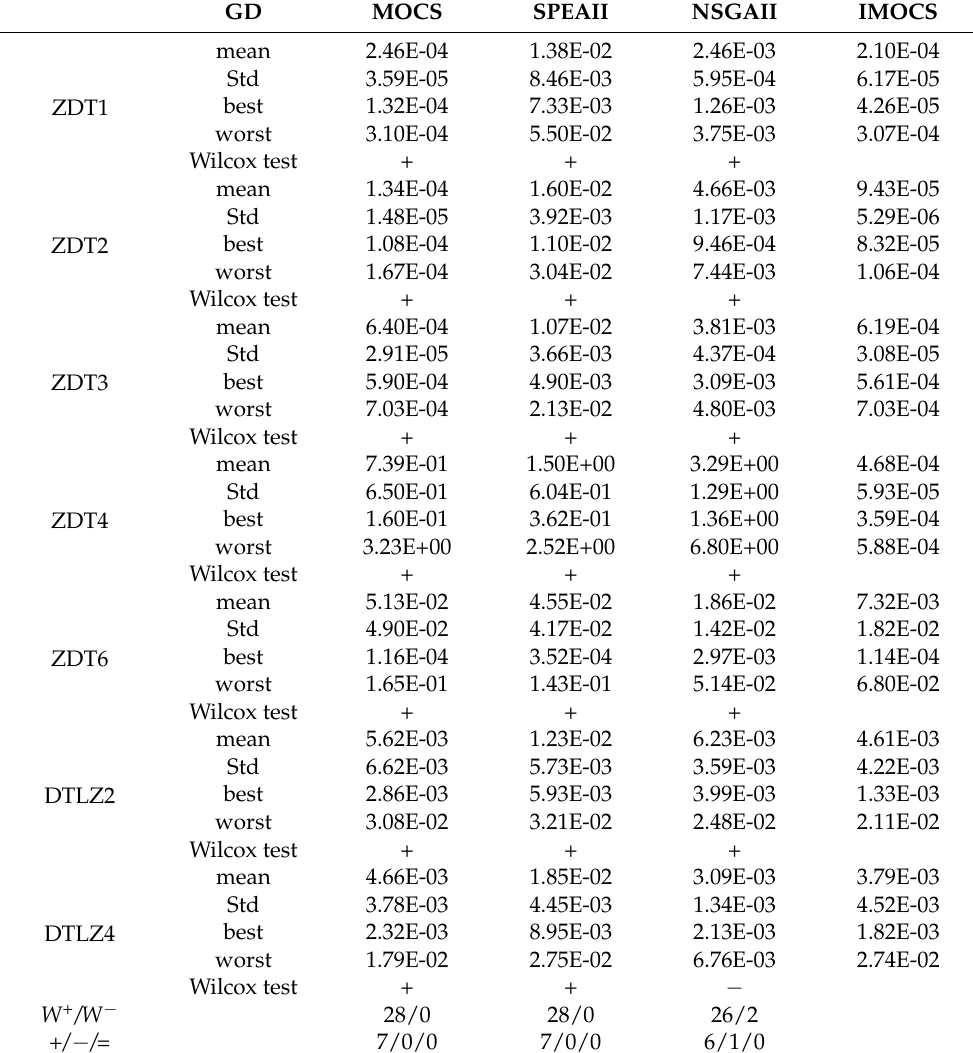
Table 3. Related statistical data based on the